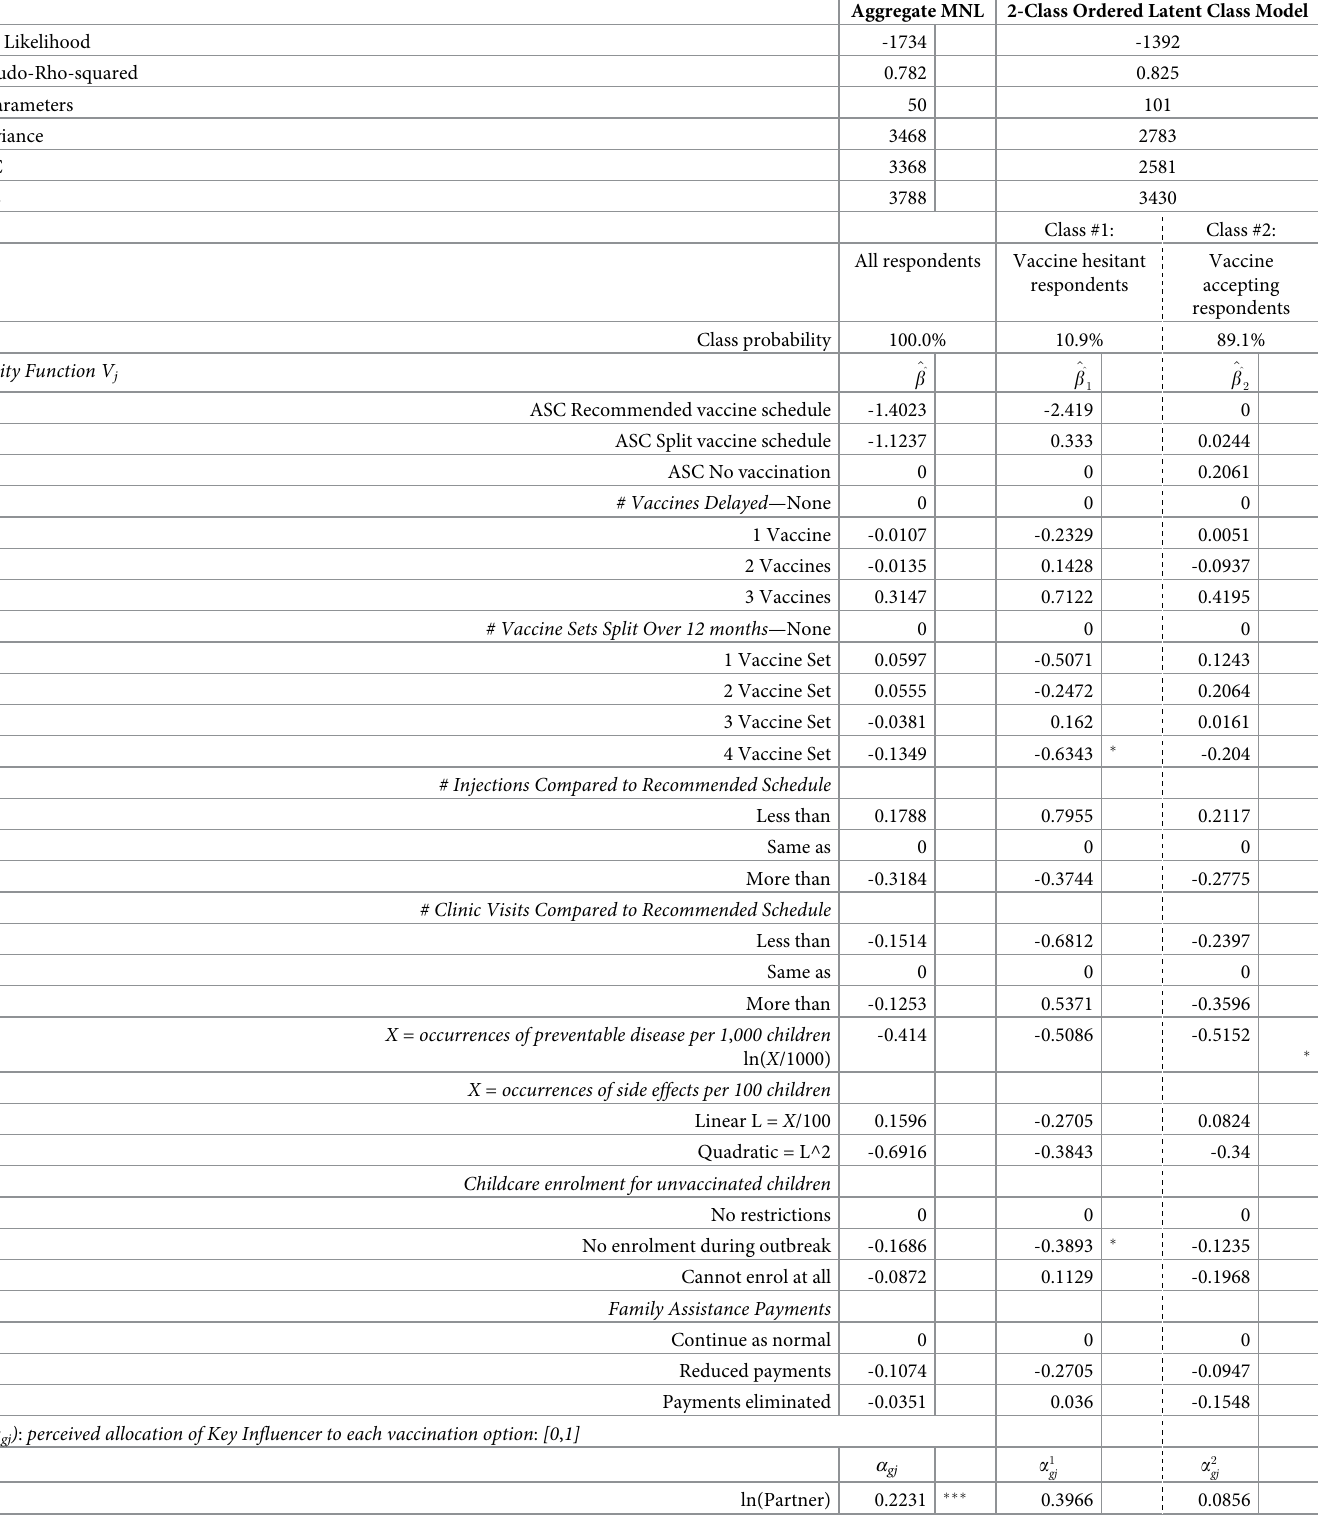
Table 4. DCE results based on an aggregate MNL and a 2-class ordered latent class